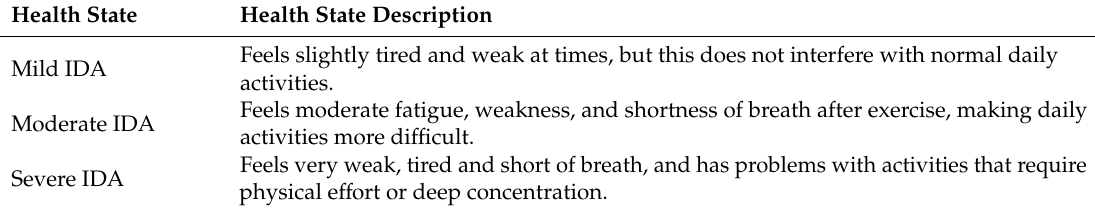
Table 2. Iron deficiency anemia severity levels and health state descriptions from the Global burden of disease 2013 study